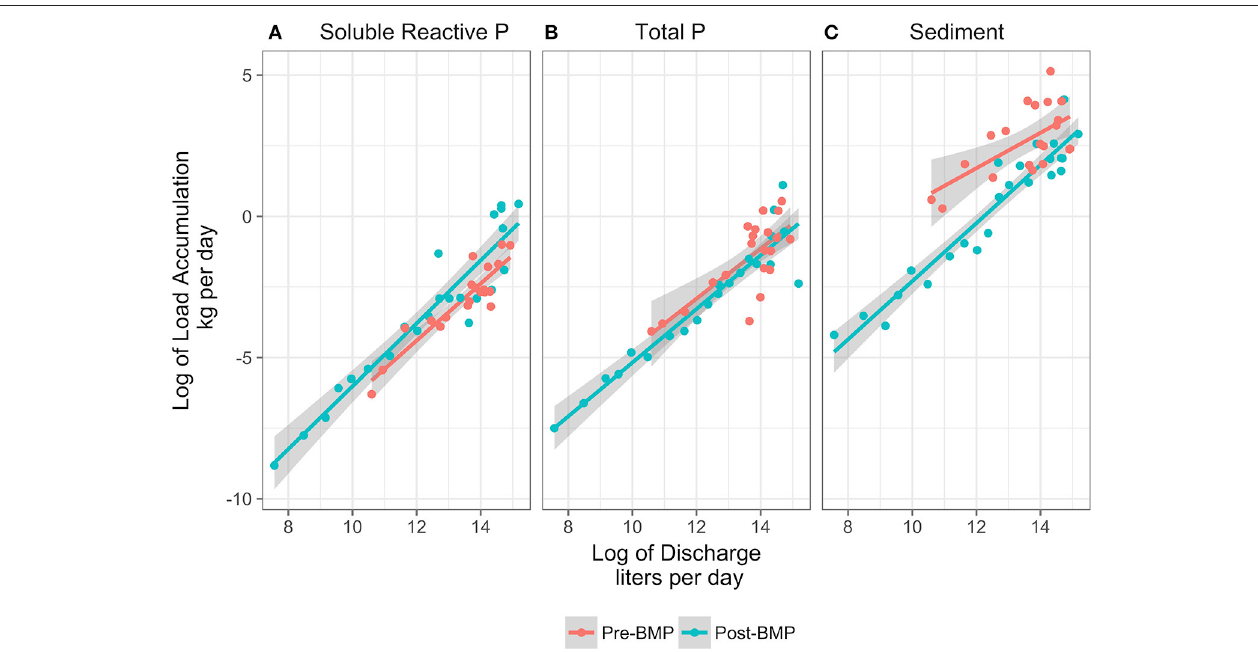
FIGURE 8 | SRP (A) , TP (B) , TSS (C) load accumulations over the reach are plotted against discharge on a log-log scale. Pre-BMP accumulations are plotted in red while post-BMP accumulations are plotted in blue. Points represent observed accumulations while lines represent the simple linear regression model for the data. Gray shaded zones represent error associated with the best-fit lines for each time period. Table 3 outlines statistics of the linear regressions.